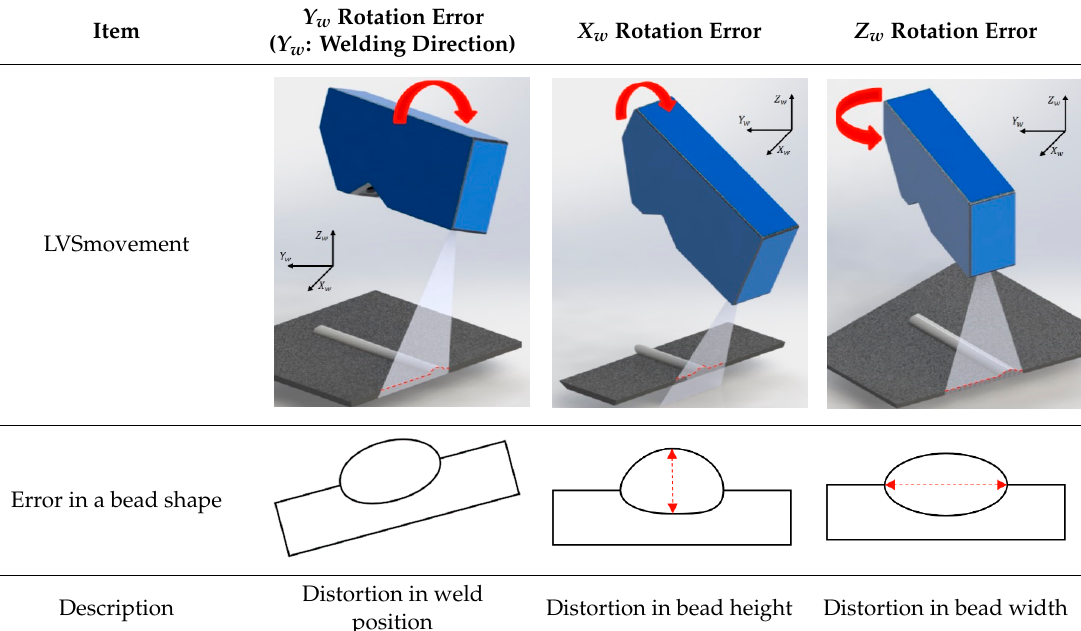
Table 3. Errors caused by LVS rotations.